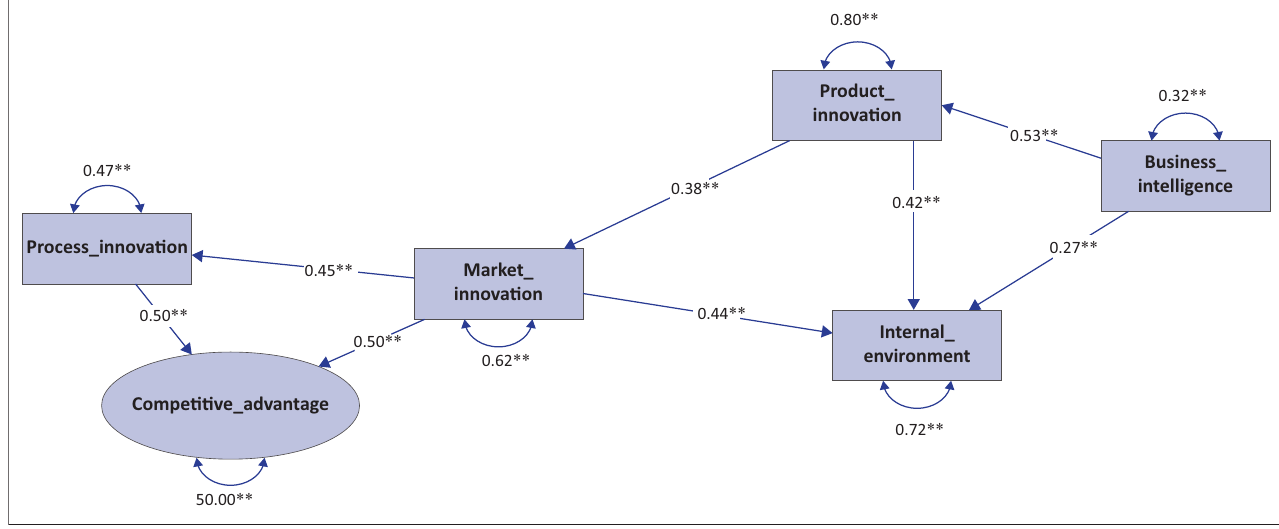
FIGURE 3: Structural model